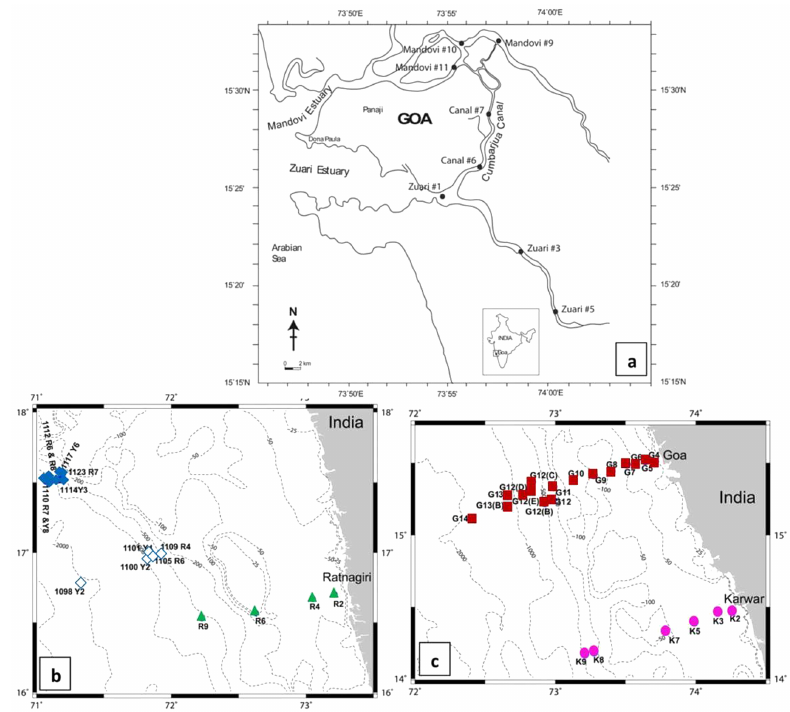
Figure 1. Sediment sampling locations; (a) within the Mandovi–Zuari estuary confluence (insert shows location relative to the Indian sub- continent as a whole), (b) Yokosuka (north and south) and Ratnagiri transects, (c) Goa and Karwar transects. Locations of panels (b) and (c) are immediately north and south of the Mandovi–Zuari confluence shown in panel (a) , respectively. Station labels are as defined in the legend to Fig.